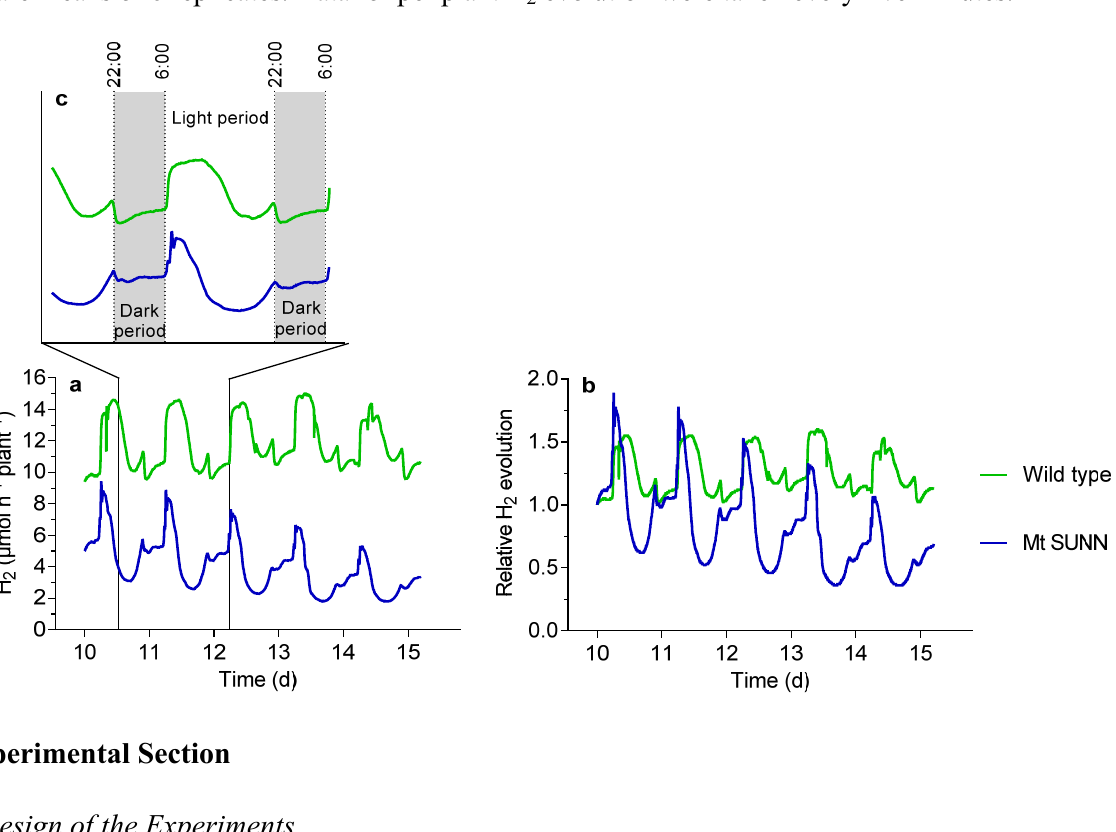
Figure 6. ( a ) Apparent nitrogenase activity (ANA), and ( b ) relative nitrogenase activity of M . truncatula wild-type and sunn plants at day 10 through 15 of the P-depletion treatment. The data in ( c ) show a period of 36 h with the dark periods indicated by grey color. Data are means of 6 replicates. Data for per plant H evolution were taken every five 2